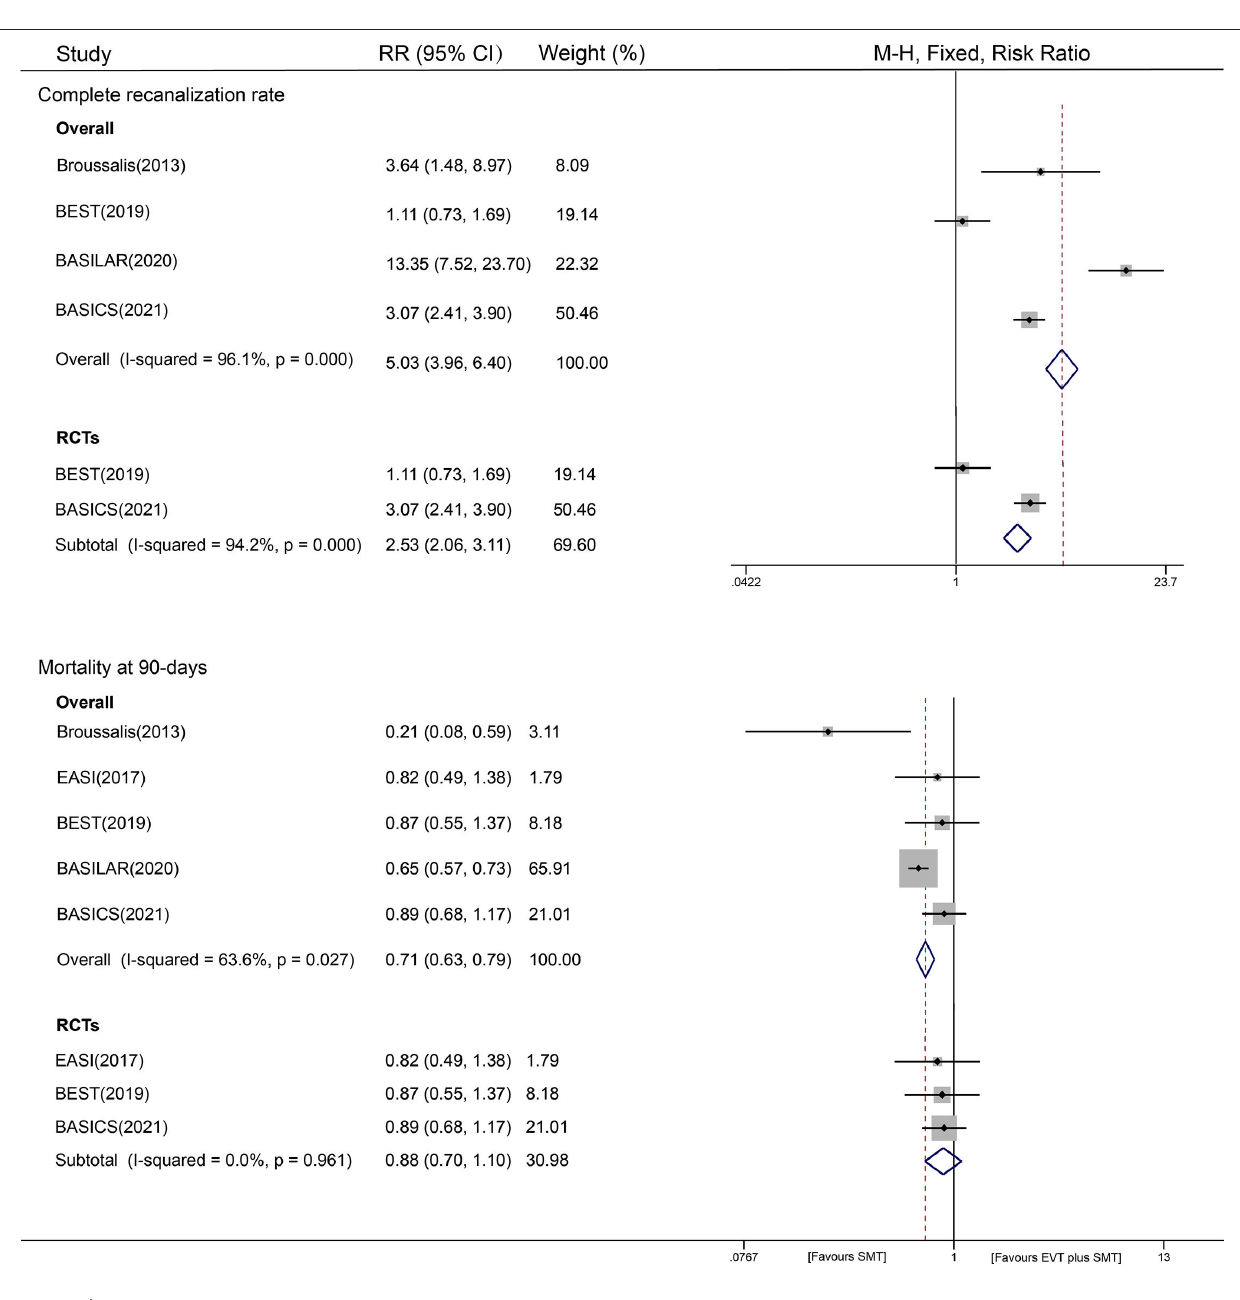
FIGURE 3 | Forest plot of completed recanalization and 90-day mortality with fixed-effect